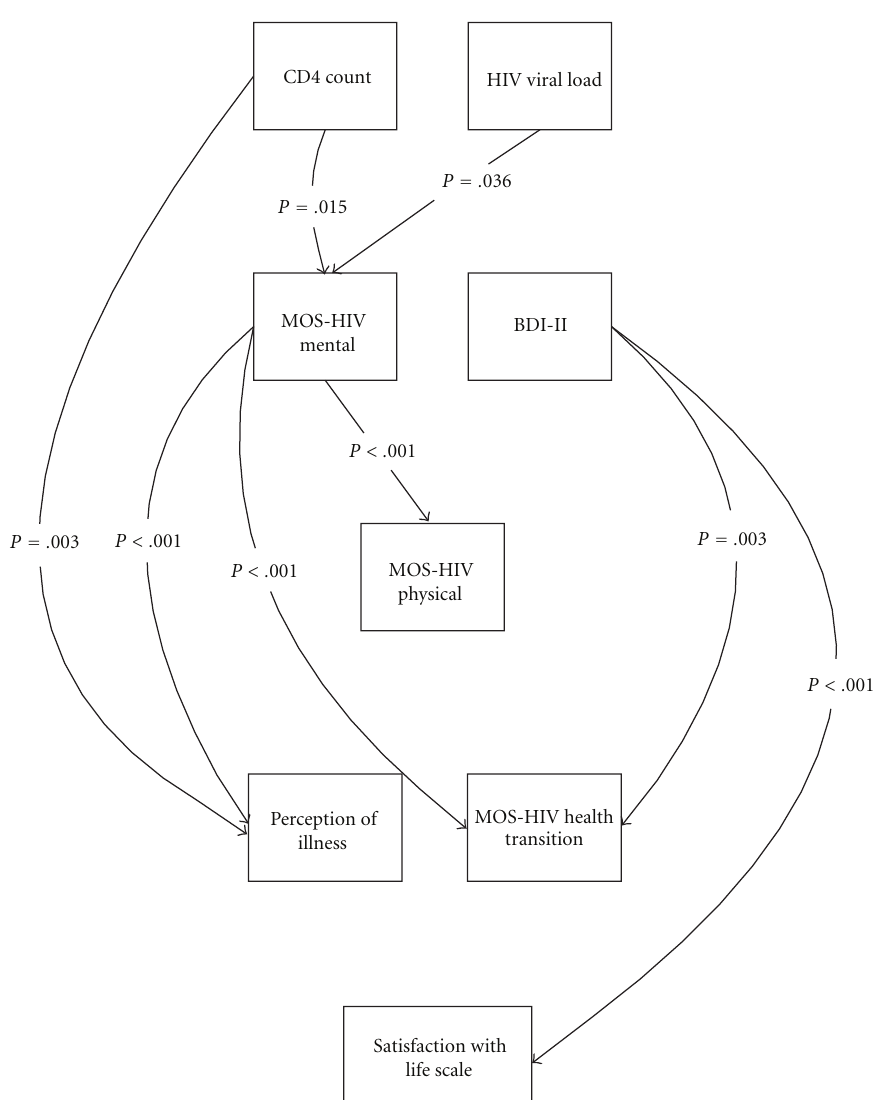
Figure 3: SEM with significant measured modeled pathways retained ( n =